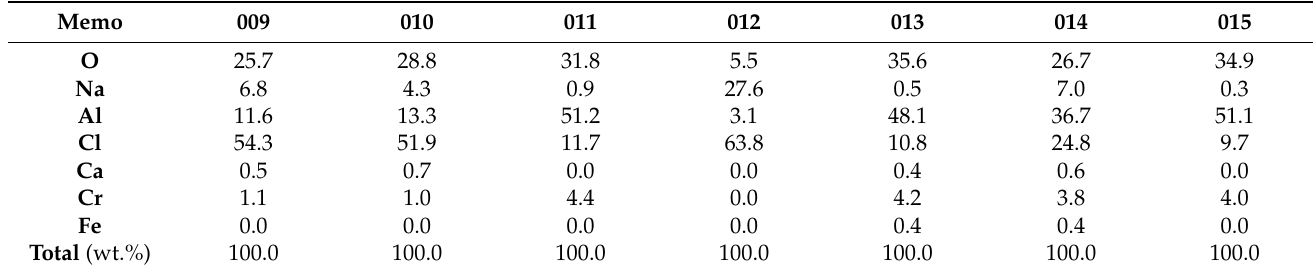
Figure A2. SEM image of the Al 2 O 3 sample obtained by calcination of ACH at 800 °C for 60 min in the air with the outlined analyzed areas by EDX (the XRD pattern is Figure 8a). Table A1. The elemental composition of the outlined areas from Figures A1 and A2 measured by